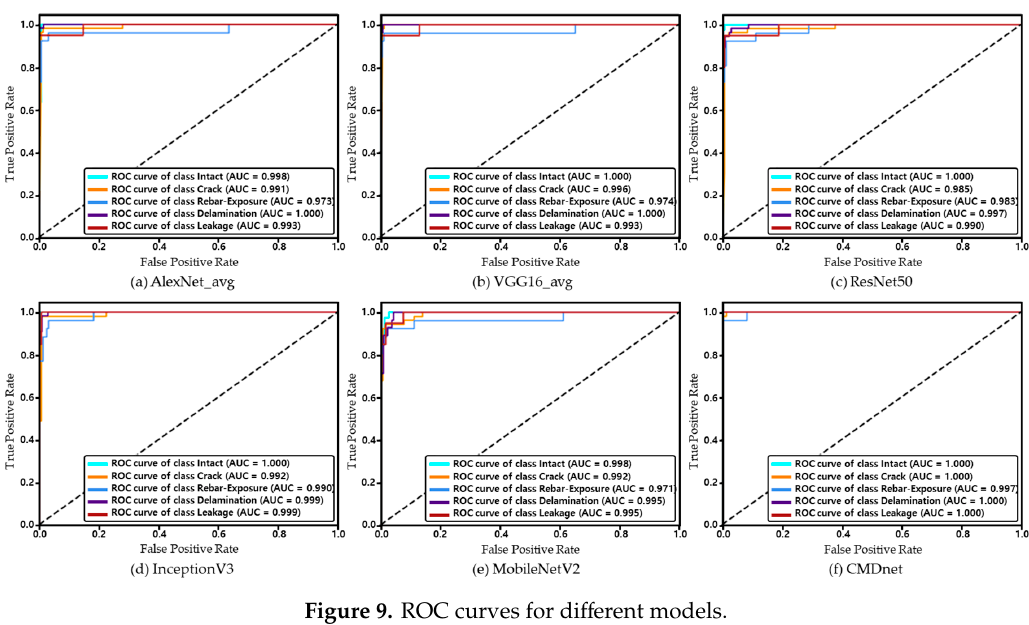
Figure 9. ROC curves for different models.